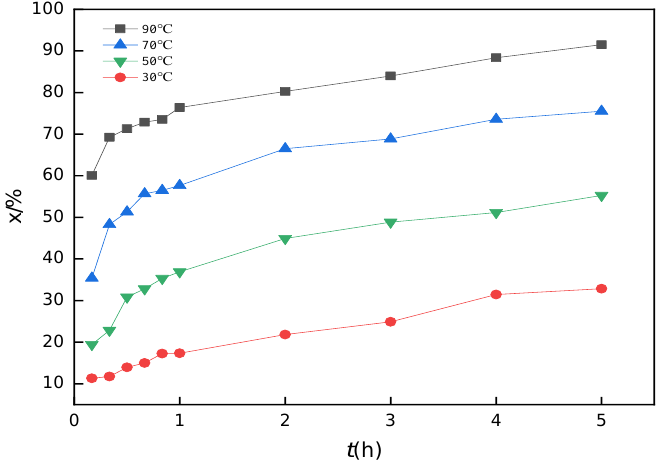
Figure 13. Effects of temperature on the extraction ratios of iron ions.